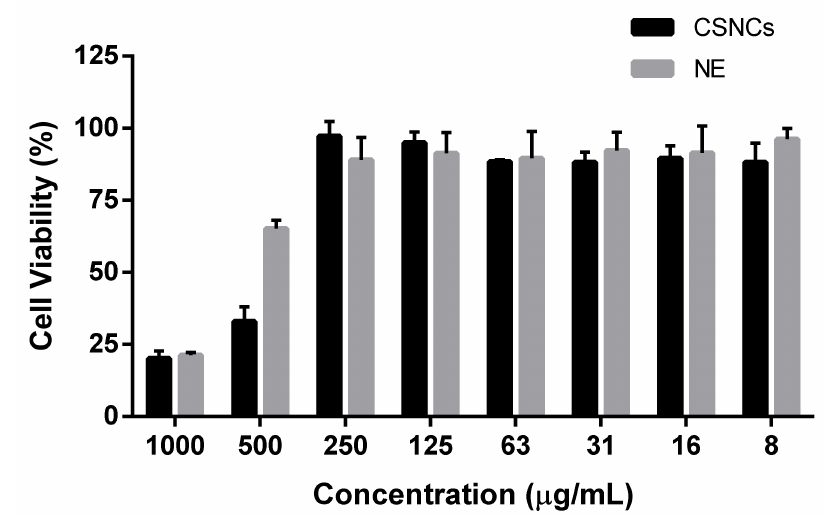
Figure 4. Raw 264.7 cell viability upon 4 h contact with different concentrations of chitosan nanocapsules (CSNCs) or their nanoemulsion (NE). Measurements were taken at 24 h post incubation. (mean ± SD, n = 3).